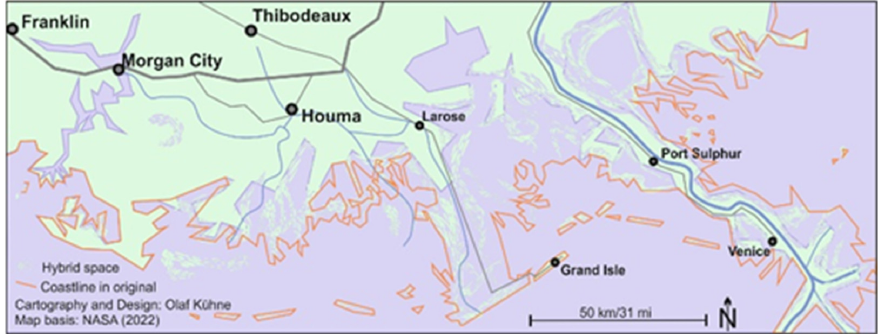
Figure 3. Generalized cartographic representation based on a recent NASA satellite image from May 12, 2022 [55]. In comparison to Figure 2, the shrinkage of the areas classified as land is particularly significant. Strongly pronounced is the intrusion of marine water as well as of spaces that exhibit hybrid land–sea characteristics. Here, too, there is a strong divergence between the coastline and the land or hybrid areas (own representation, as in [54]).